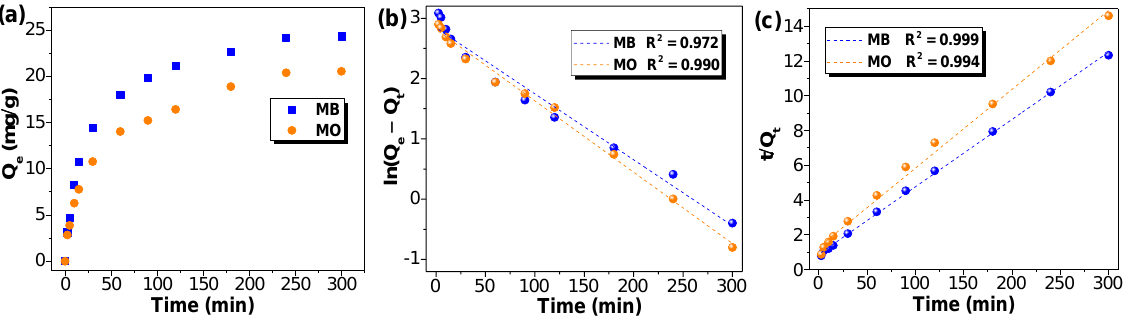
Figure 6. ( a ) Effect of contact time on the adsorption of MB and MO by mPVA/AC CG at pH 7. The initial dye concentration was 0.1 mM. ( b ) Plots of ln(Q e − Q t ) against t based on the pseudo-first-order kinetic model. ( c ) Plots of t/Q t against t based on the pseudo-second-order kinetic model. Table 2. The kinetic parameters for the adsorption of MB and MO onto the mPVA/AC CG.